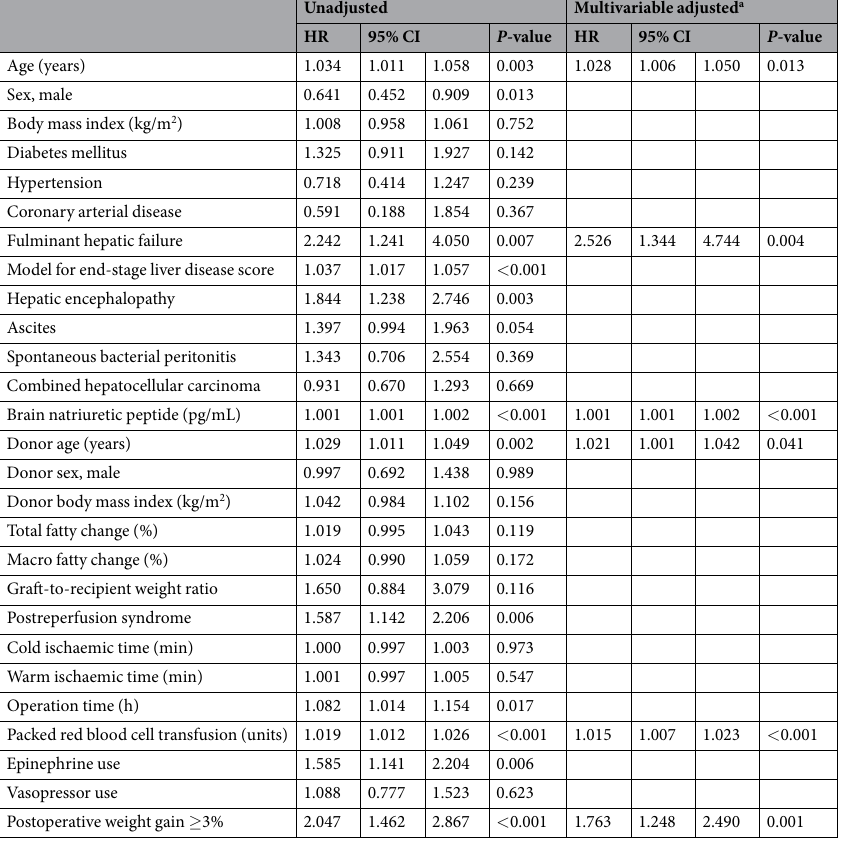
Table 2. Cox proportional hazards regression analysis of factors associated with graft failure in living donor liver transplantation recipients. HR, hazard ratio; CI, confidence interval. a Adjusted for all variables in the